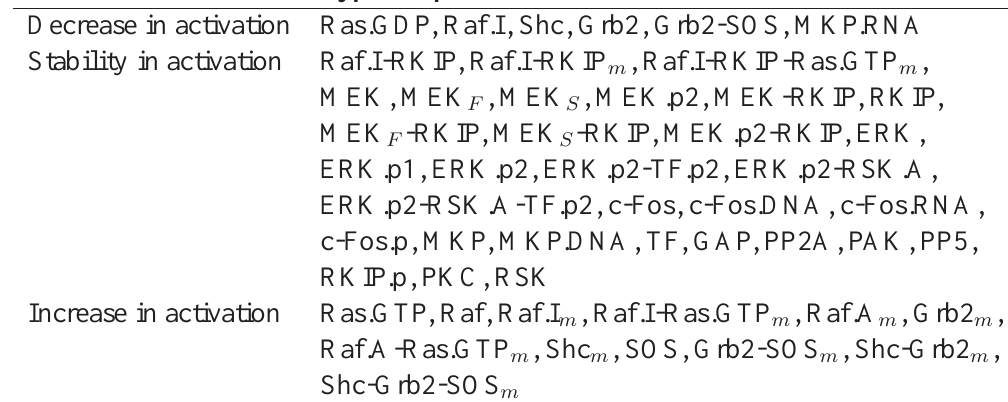
Table 2: Changes in activities of each protein of the MAPK pathway under the first and the third scenario when the second scenario is accepted as the natural activation of the cell and t = 20